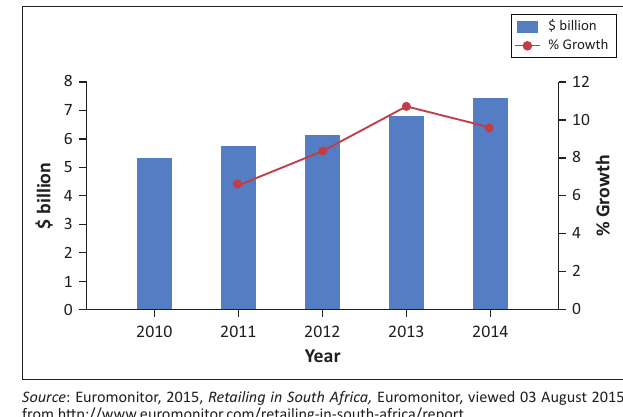
FIGURE 2: Retail trade sales for 2014. FIGURE 3: South African apparel retail industry value: $ billion,